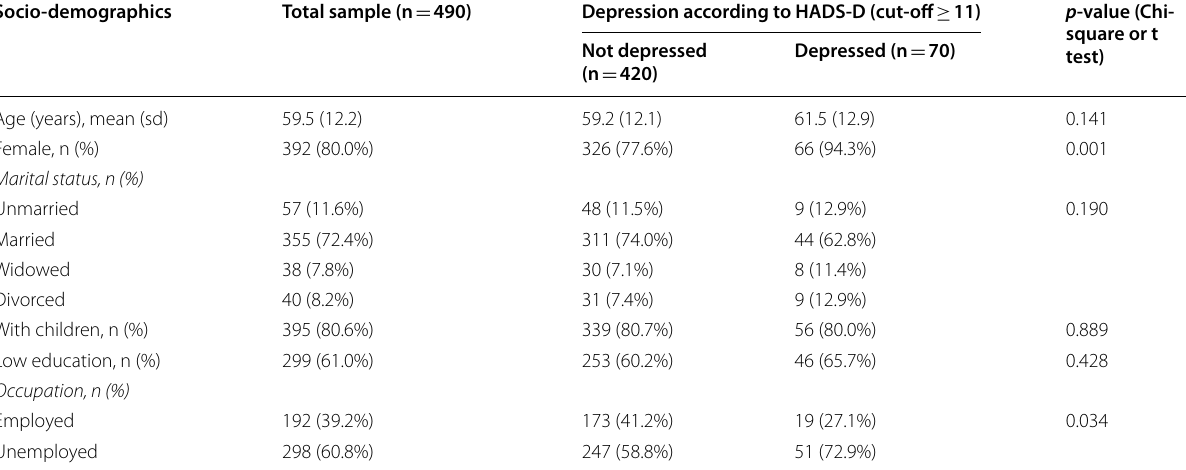
Table 1 Socio-demographic characteristics of RA patients and their association with depression (n